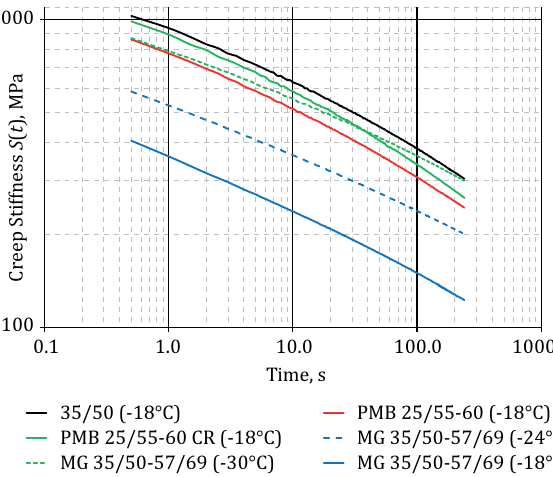
Figure 3. Curves of the creep stiffness modulus versus time for medium consistency bitumens